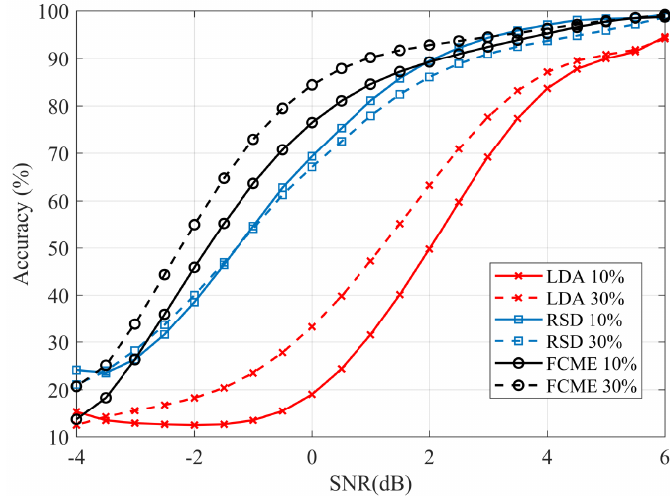
Figure 4. Signal samples detection efficiency as an average ratio of correctly recognized signal samples.